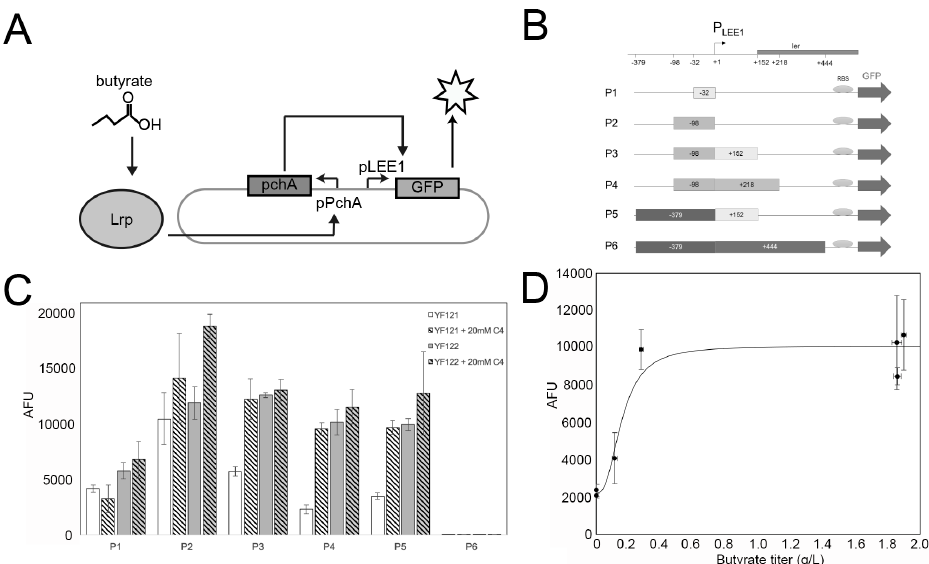
Figure 3. Construction of C4 sensor system in EcN. ( A ) Schematic of the in vivo butyrate sensor system in EcN. ( B ) Six different reporter plasmids (P1-P6) with distinct lengths of P LEE1 promoters; +1 is the transcription start site (TSS). ( C ) Fluorescent signal intensities of the YF121 (negative control) and YF122 (test) strains with plasmids P1-P6, cultured in the absence or presence of 20 mM sodium butyrate (C4). The data were calculated from at least three biological replicates. ( D ) Fluorescence measurements with respect to butyrate titer for seven different growth conditions; strains YF121, YF122, and YF126 containing plasmid P4 were cultured with and without 20 mM exogenous sodium butyrate. In addition, YF126 was cultured with isopropyl- β -D-thiogalactoside (IPTG) and no added butyrate).